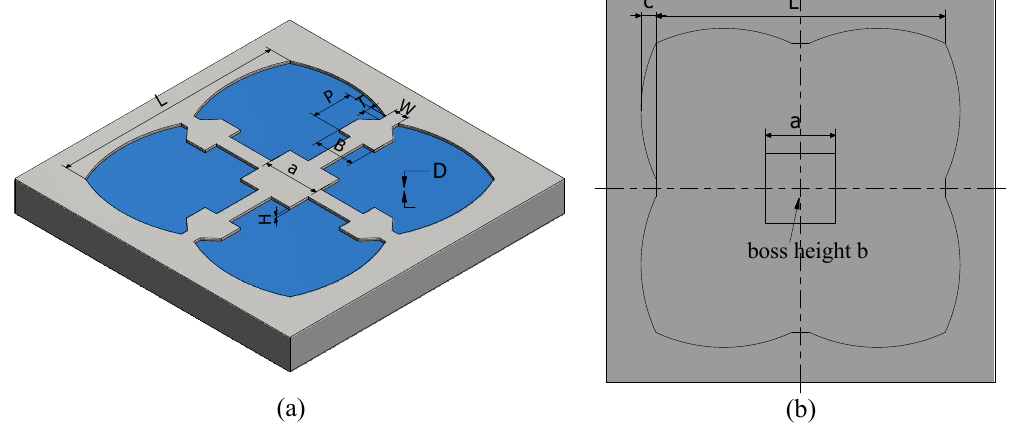
Figure 5. ( a ) Isometric view and ( b ) back view of the PMNBCB